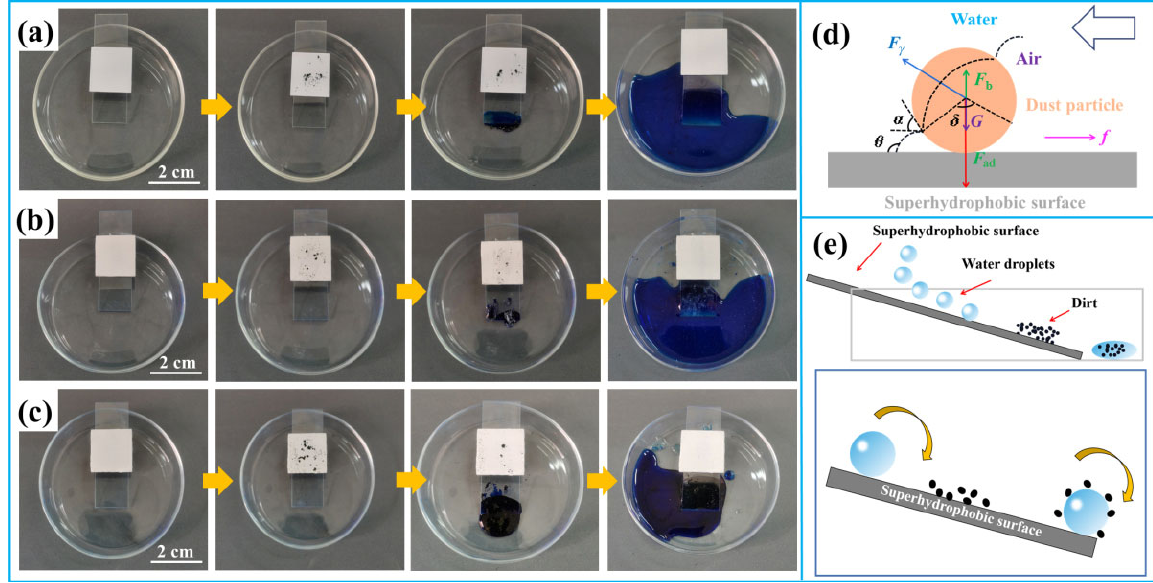
Fig. 12 Self-cleaning processes of (a) decoupling, (b) nano, and (c) coupling coatings. (d) Force analysis of a particle leaving off a superhydrophobic surface. Reproduced with permission from Ref. [59], ©American Chemical Society 2017. (e) Self-cleaning mechanism of the superhydrophobic